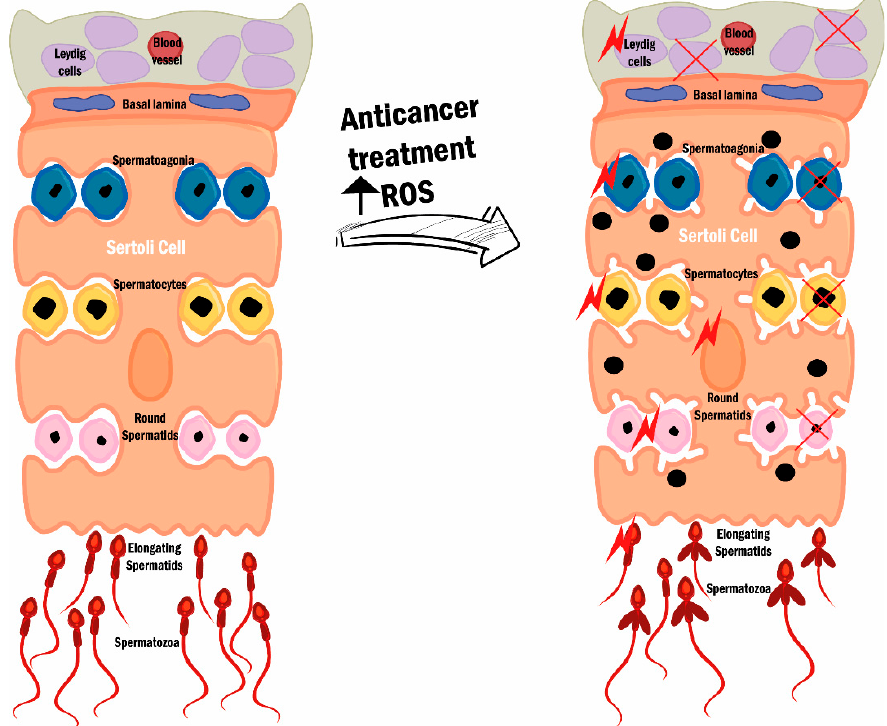
Figure 4. Spermatogenesis dysfunction after anticancer treatment. ROS overproduction due to treat- ments depletes the antioxidant systems, leading to OS. Both the normal and abnormal spermatozoa can be damaged by ROS; however, in the treatment case (right side), damage is more prevalent since ROS are present/produced in higher quantity due to anticancer treatments. OS impinges on sperma- tozoa (represented by the red stars) and damages to cell/sperm and mitochondria membranes, DNA damage, and defects in the sperm mid-piece and axonemal region can be observed. The establishment of this compromised process leads to abnormal semen characteristics and is responsible for the fertility decline present in men submitted to anticancer treatments. Reactive oxygen species (ROS).